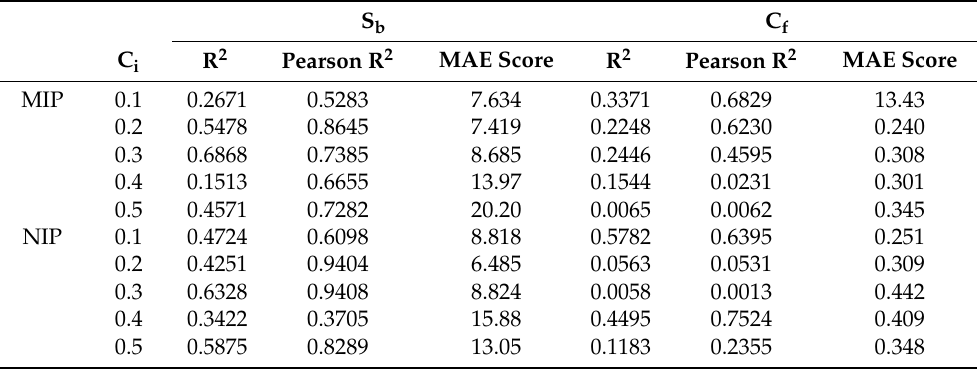
Table 6. Analysis of the error and correlation of the test datasets at a given C i value for the graph convolution